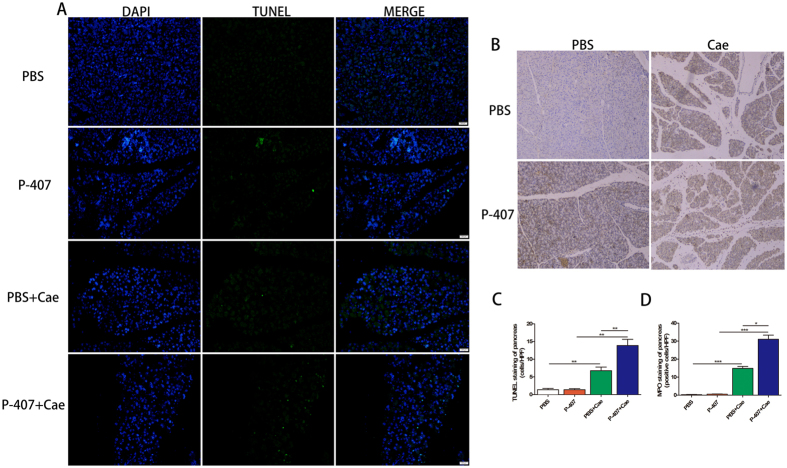
HTG was induced by long term 28 days P-407 (0.5 g/kg) injection, Mice was treated with standard dose Cae (50 ug/kg) to induced AP model.n = 6–8 each group. (A) Representative immunohistochemistry images for TUNEL staining in pancreatic tissue and (B) for MPO stained sections in pancreatic tissue. Immunohistochemistry stained sections of pancreas in magnification 100X. (C) The apoptotic cells counting of TUNEL staining. (D) The neutrophils counting of MPO staining. *P < 0.05, **P < 0.01, *** < 0.001.